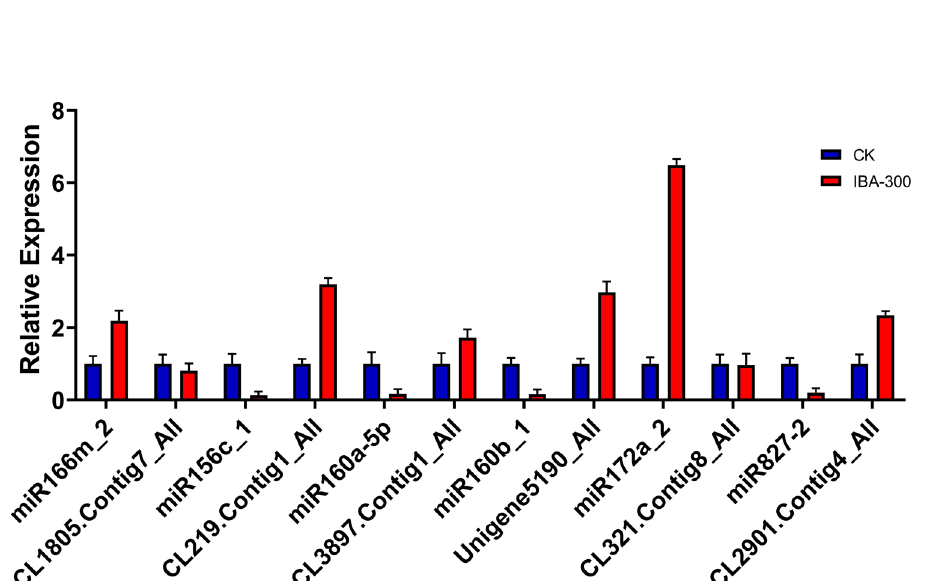
Figure 5. Relative expression levels of six miRNAs and target genes. Actin6 was used as a reference for the mRNA qRT-PCR while U6 snRNA was used as a reference for the miRNA qRT-PCR. The expression in the control was set to 1.0. Mean values of three replicates are shown with standard error